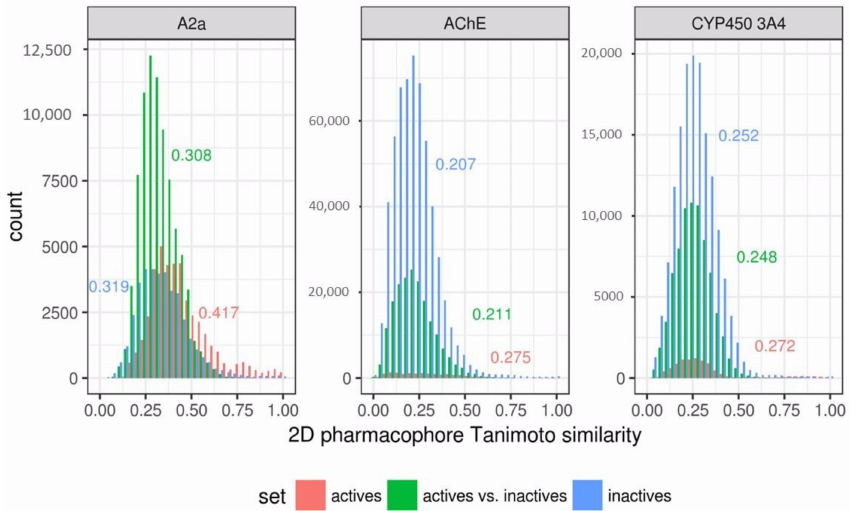
Figure 9. Distribution of pairwise Tanimoto similarity calculated based on 2D pharmacophore fingerprints for subsets of active and inactive compounds of each data set. Numbers are median pairwise Tanimoto values for each